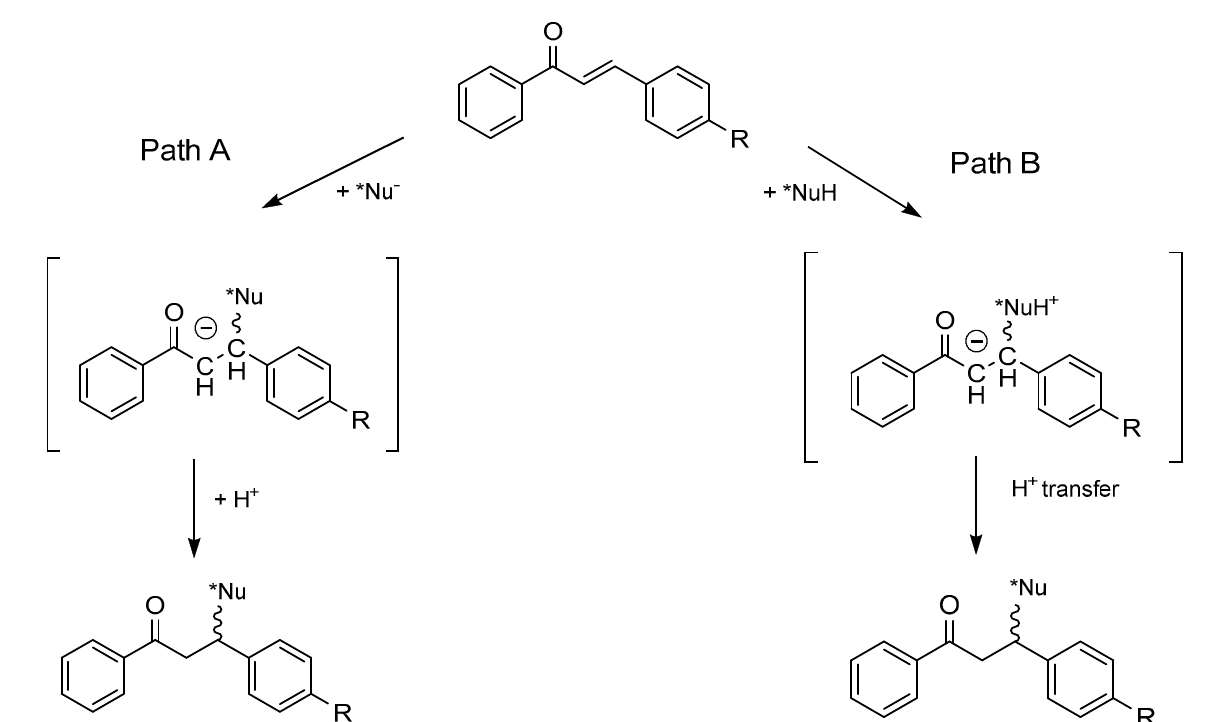
Figure 2. General mechanisms of the addition reaction of nucleophiles onto the activated double bonds of chalcones.